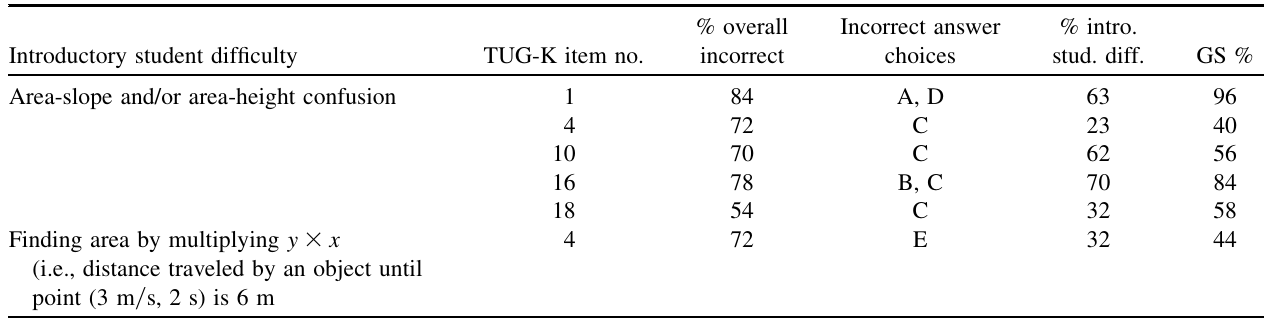
TABLE V. Introductory student difficulties related to determining areas under curves, items on the TUG-K which uncover these difficulties (TUG-K item no.), percentage of introductory students who answer the items incorrectly (% overall incorrect), incorrect answer choices which uncover these difficulties, percentage of introductory students who have these difficulties based on their selection of these answer choices (% intro. stud. diff.), and percentage of graduate students who select these answer choices as the most common incorrect answer choices of introductory students (GS %). For convenience, short descriptions of the questions are given